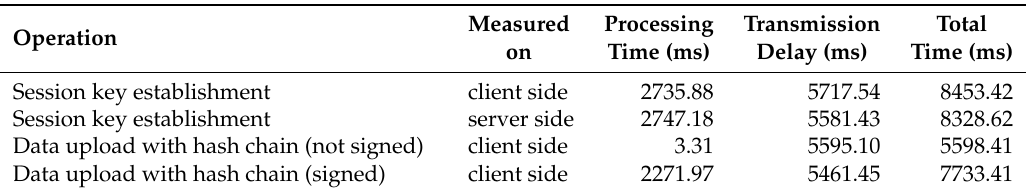
Table 5. Protocol processing time